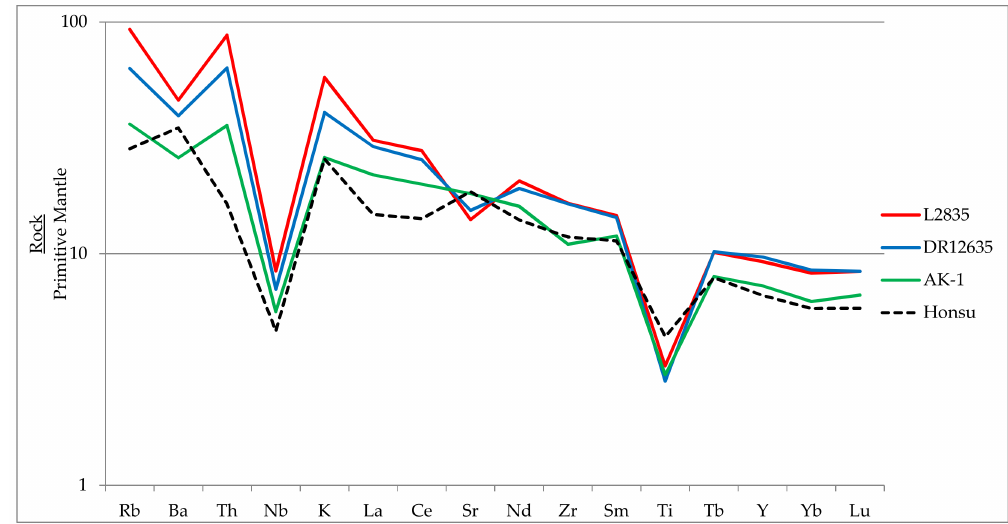
Figure 6. Normalized diagram to primitive mantle showing typical volcanic rocks from supra subduction zone. Data source: Primitive mantle [32], Honshu [33].